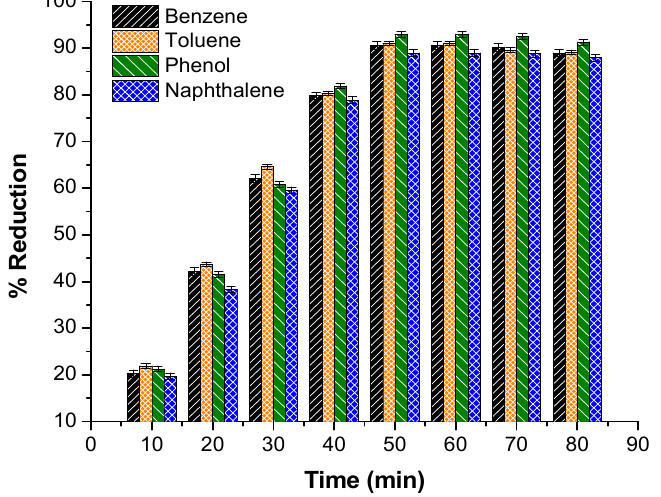
Figure 8. Effect of time on removal of HC using TiO 2 /AC ( 35 °C temperature, pH 3, and 1 h contact time; TiO 2 /AC dose 500 mg/100 mL feed volume ).